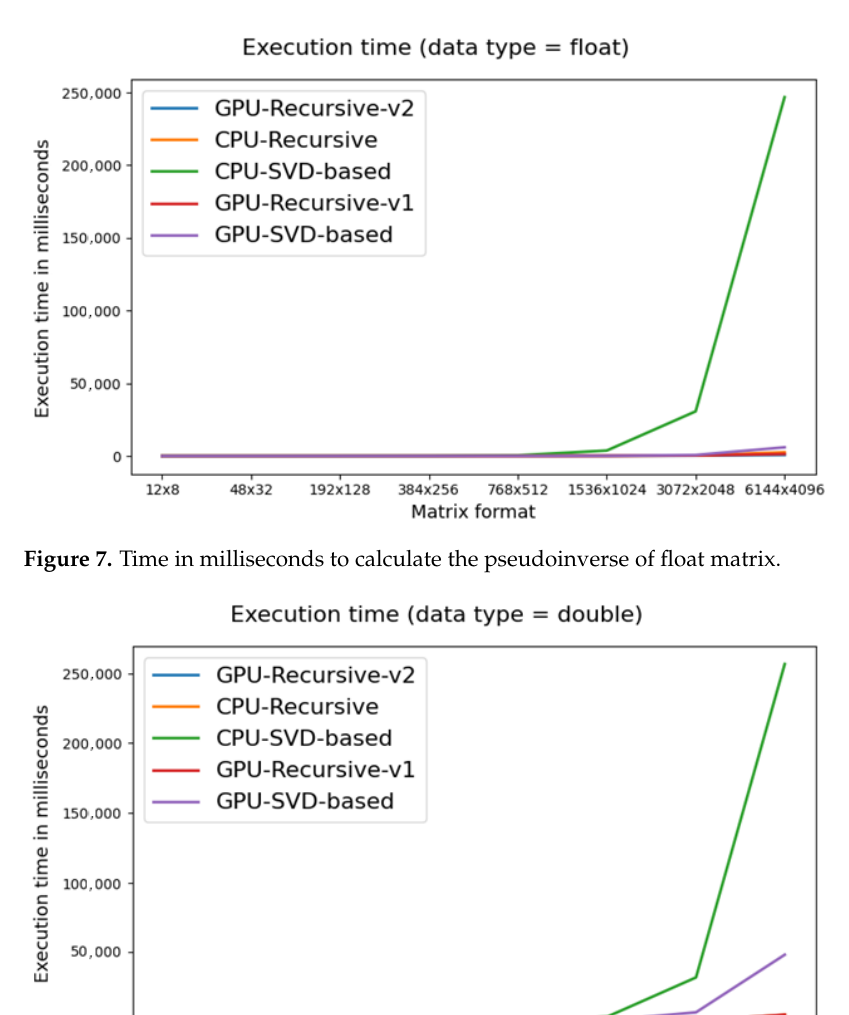
720.2 Table 2. Time in milliseconds to calculate the pseudoinverse for double matrices.